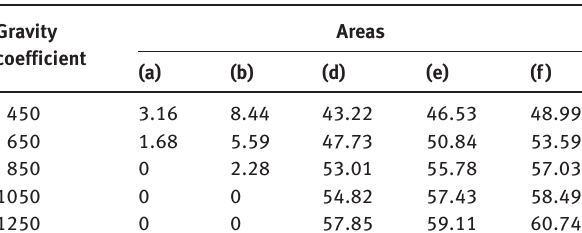
Table 2: Variations of volume fraction of V-containing spinel phase in different areas of the samples with different gravity coefficient